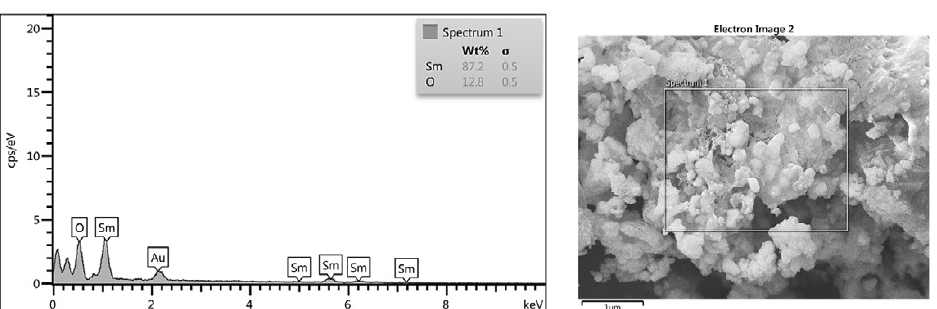
Fig. 6. TEM images of Sm 2 O 3 NPs